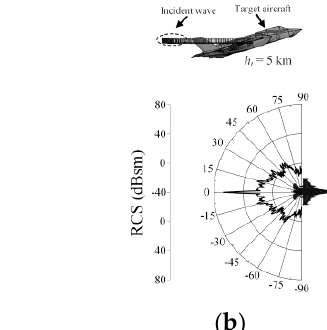
Figure 6. Scan loss and target RCS according to scan angle: ( a ) scan loss according to scan angle; ( b ) RCS of a target aircraft.